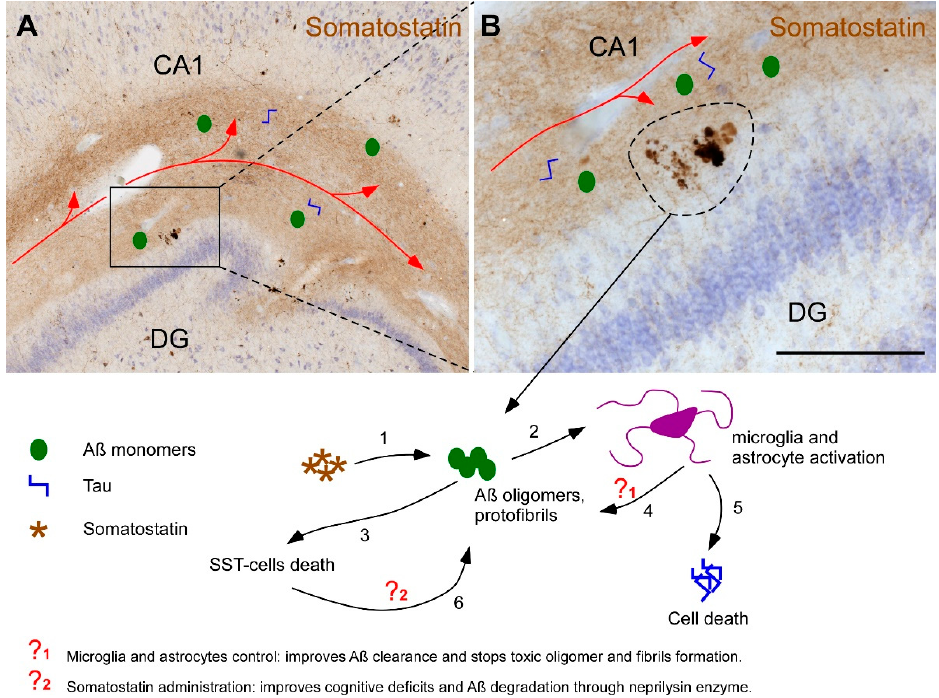
Figure 8. Involvement of somatostatin and glia in the etiology of Alzheimer’s disease. The hippocampus receives afferences from the entorhinal cortex (red line in images A and B ). Pathological proteins A β and Tau can spread through this network reaching the molecular layers of CA-DG hippocampal regions. Interestingly, molecular layer contains the highest amounts of somatostatin which in turns favors the oligomerization of A β (1). These oligomers and fibrils activate microglial and astroglial populations (2) and cause somatostatin-positive cells death (3). Active astrocytes and microglia have a dual role by promoting A β clearance from the extracellular space (4) but also enhancing neuroinflammatory process that breaks cell homeostasis, accumulates intracellular toxic hyperphosphorilated Tau and causes cell death (5). Since somatostatin peptide enriches the expression of the main A β degrading enzyme neprilisyn, the death of somatostatin-positive cells, secondarily stimulates the accumulation of A β oligomers and fibrils (6). One of the most important therapeutic approaches is, therefore, focused on the regulation of microglia and astrocytes (? 1 ), particularly in the management of their state of activation and their capabilities to stop the formation of A β oligomers and remove it from the extracellular space as well. Other potential therapeutic strategy is using somatostatin as a transcriptional factor of neprilisyn degrading enzyme (? 2 ). Therefore, known somatostatin levels and/or the reactive state of astrocytes could serve for early diagnosis of Alzheimer’s disease. Scale bar A = 750 µ m, B = 200 µ